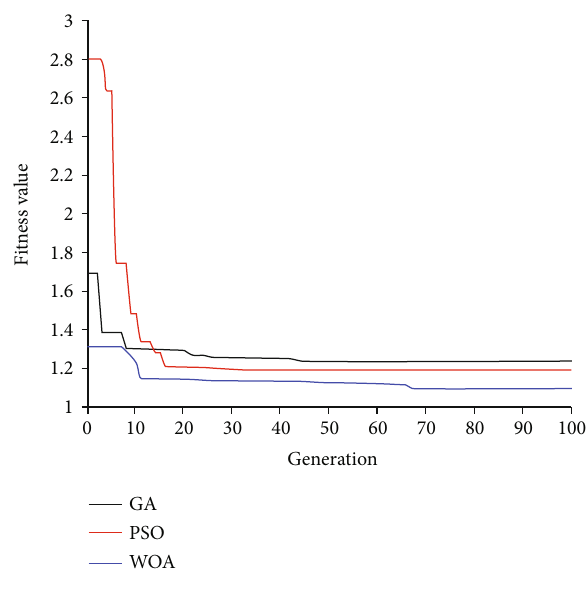
Figure 9: Convergence graph for WOA.